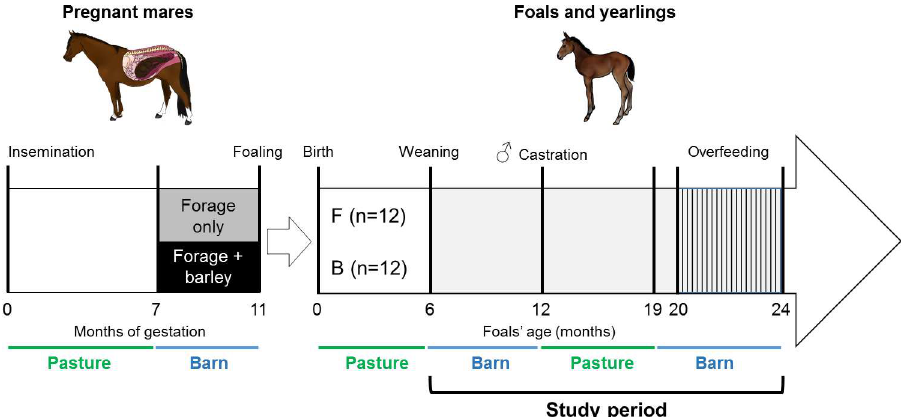
Fig 1. Experimental design from insemination of the broodmares until foals’ 24 months of age. From insemination until 7 months of gestation, pregnant mares were managedas one same herd in the same pasture. From the 7 th month of gestation, they were housed in individual boxes and allocatedto one of two groups: fed with forage only (F, n = 12) or with forage and flattenedbarley (B, n = 12) until foaling. From 3 days until 6 months of age, foals were in pasture with their dams [31]. They were weanedat 6 months and housed in open barns and fed the same amount of feed, followingthe INRA recommendationsfor growingfoals [29]. Colts were castrated at 12 months as a routine procedure. From 12 to 19 months of age, all yearlingswere managedin the same pasture. At 19 months of age, all yearlingswere housedin open barns and between20 and 24 months of age, they were over nourishedusing an automatic feeder (+140%of INRA energy requirements, +135% of NRC energy requirements